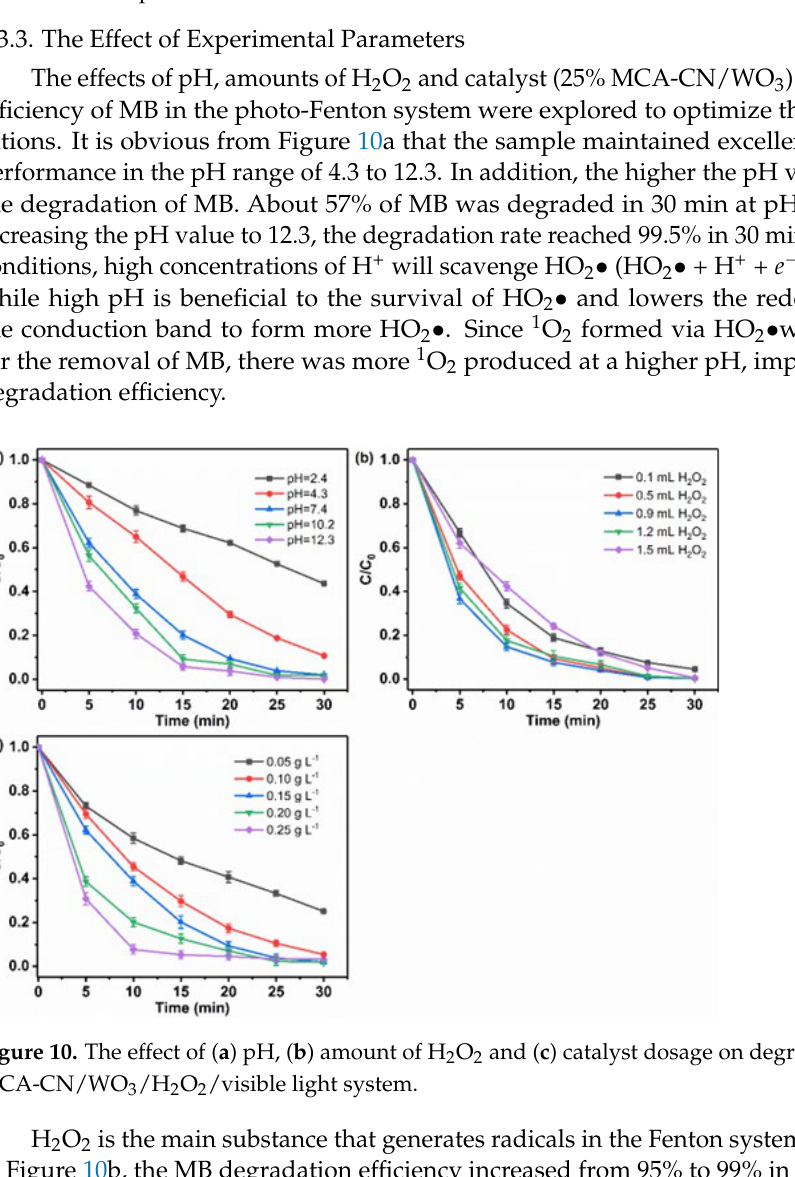
Figure 9. Degradation rate of MB with ( a ) different loading amount of WO 3 and ( b ) different synthesized temperatures.